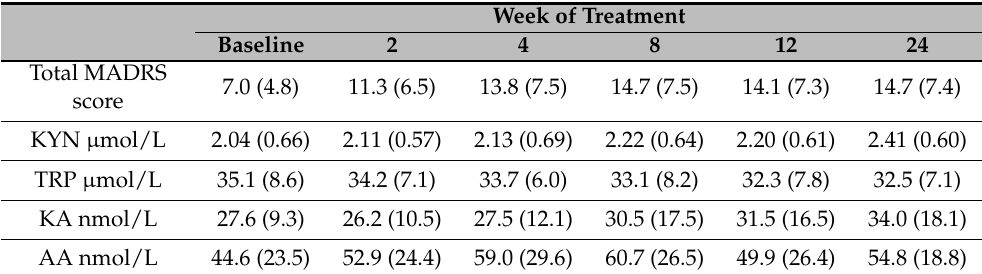
Table 3. Means and standard deviations of MADRS score and KYN, TRP, KA, and AA concentrations in study cohort (N =